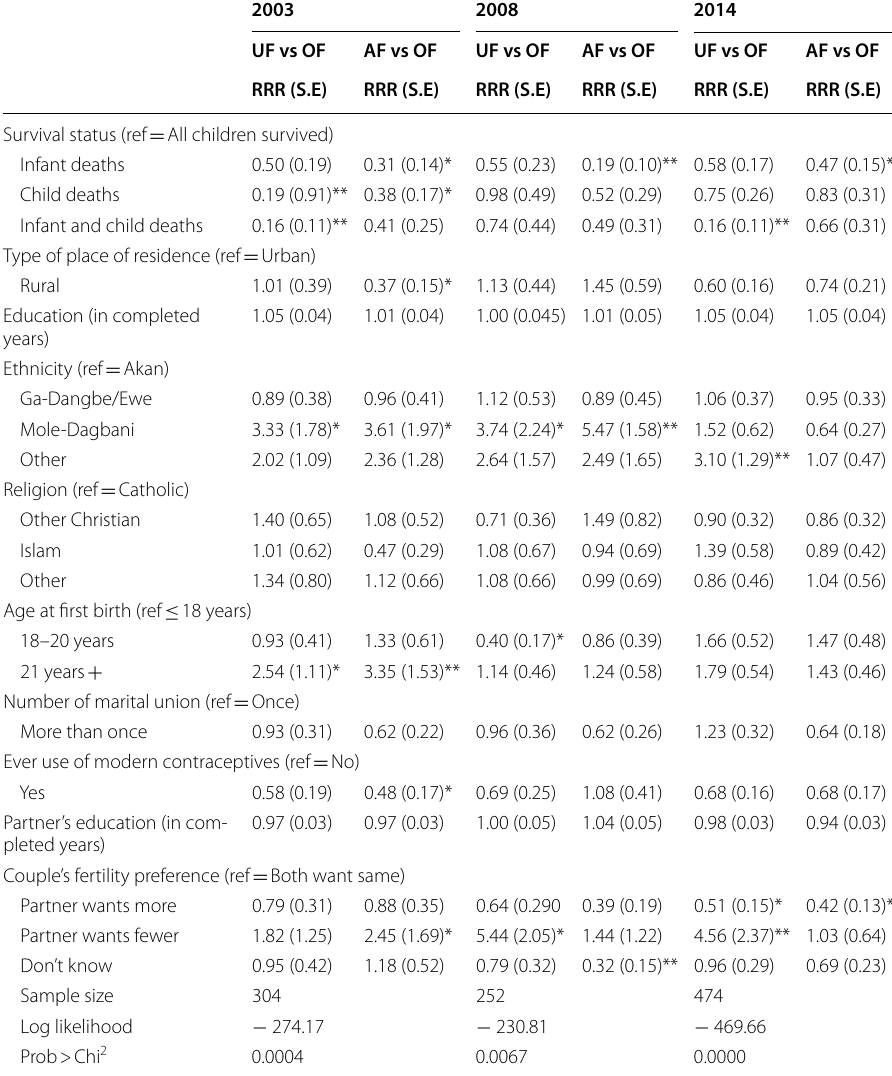
Table 2 Results of multinomial logistic regression of fertility gap in